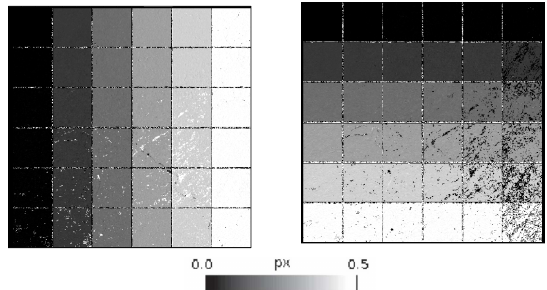
Figure 5 : Medicis 2D disparity map published by Rosu et al.. These maps are obtained with Medicis V9.1 and with the default parameters, except the correlation window (9*9), the initial resemblance threshold (0.6), the final one (0.8), the initial disparity (1 in line and -1 in column) and the exploration radius (2 in line and column). Which leads to an exploration area of [-1 ; 3] in line and of [-3 ; 1] in column, knowing that the synthetic displacement was from 0 to 0.5 pixel in column and